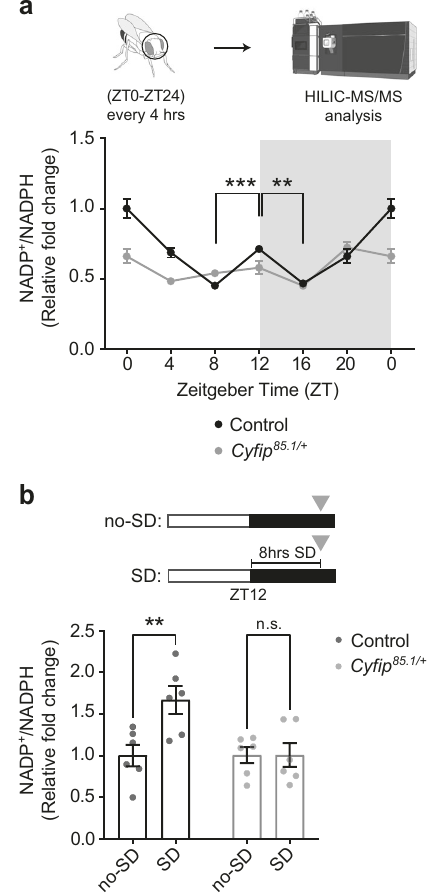
Fig.2| Cy fi p mutant fl ieshaveanimbalanceintheNADP + /NADPHratio.a Upper inset, schematic of the experimental design; lower inset, quanti fi cation of the NADP + /NADPH ratio by HILIC-MS/MS in control and Cy fi p 85.1/+ fl y heads. Control n =5, Cy fi p 85.1/+ n =5 over 24 h. n =independent samples, pool of 50 fl y heads, for each time point. Two-way ANOVA followed by Tukey ’ s multiple comparisons test; time point effect p <0.0001, genotype effect p <0.0001, interaction effect p <0.0001, F (6, 56) = 9.061, control ZT8 vs. ZT12 *** p =0.0009; control ZT12 vs. ZT16 **p = 0.0022; Cy fi p 85.1/+ ZT8 vs. Cy fi p 85.1/+ ZT12 p =0.99; Cy fi p 85.1/+ ZT12 vs. Cy fi p 85.1/+ ZT16 p =0.34; Cy fi p 85.1/+ ZT8 vs. Cy fi p 85.1/+ ZT16 p =0.74. Mean ± S.E.M. (see alsoSupplementaryData6).CreatedwithBioRender.com. b Upperinset,schematic of the experimental design. no-SD: undisturbed sleep, SD: sleep deprived. Lower inset,NADP + /NADPHratioincontroland Cy fi p 85.1/+ fl yheadsinno-SD(control, n =6, and Cy fi p 85.1/+ , n =6) and SD conditions (control, n =6, and Cy fi p 85.1/+ , n =6). n = independent samples, pool of 23 fl y heads. Two-way ANOVA followed by Sidak ’ s multiple comparisons test, sleep condition effect p =0.0217, genotype effect p =0.0243, interaction effect p =0.022, F (1, 20) = 6.165, control no-SD vs. SD ** p =0.0043; Cy fi p 85.1/+ no-SD vs. SD p >0.999, n.s. = not signi fi cant. Mean ± S.E.M. Source data are provided as a Source Data fi